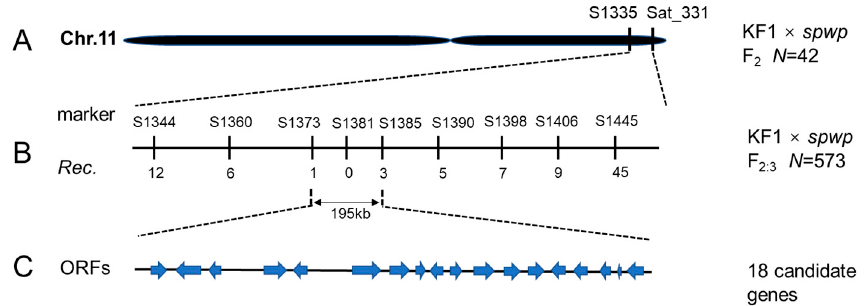
Figure 4. Fine-mapping of the spwp2 locus. ( A ): the spwp2 locus was initially mapped by single- sequence repeat (SSR) markers S1335 and Sat_331 on chromosome (Chr.) 11 using the F 2 population of KF1 × spwp . ( B ): the position of the spwp2 locus was finally delimited to a 195 kb region between SSR markers S1373 and S1385. The numerals below the markers indicate the number of identified recombinants ( Rec. ). ( C ): eighteen predicted open reading frames (ORFs) existed in the 195 kb fine-mapping interval according to the Williams 82 reference genome ( Glycine max Wm82.a4.v1 ).